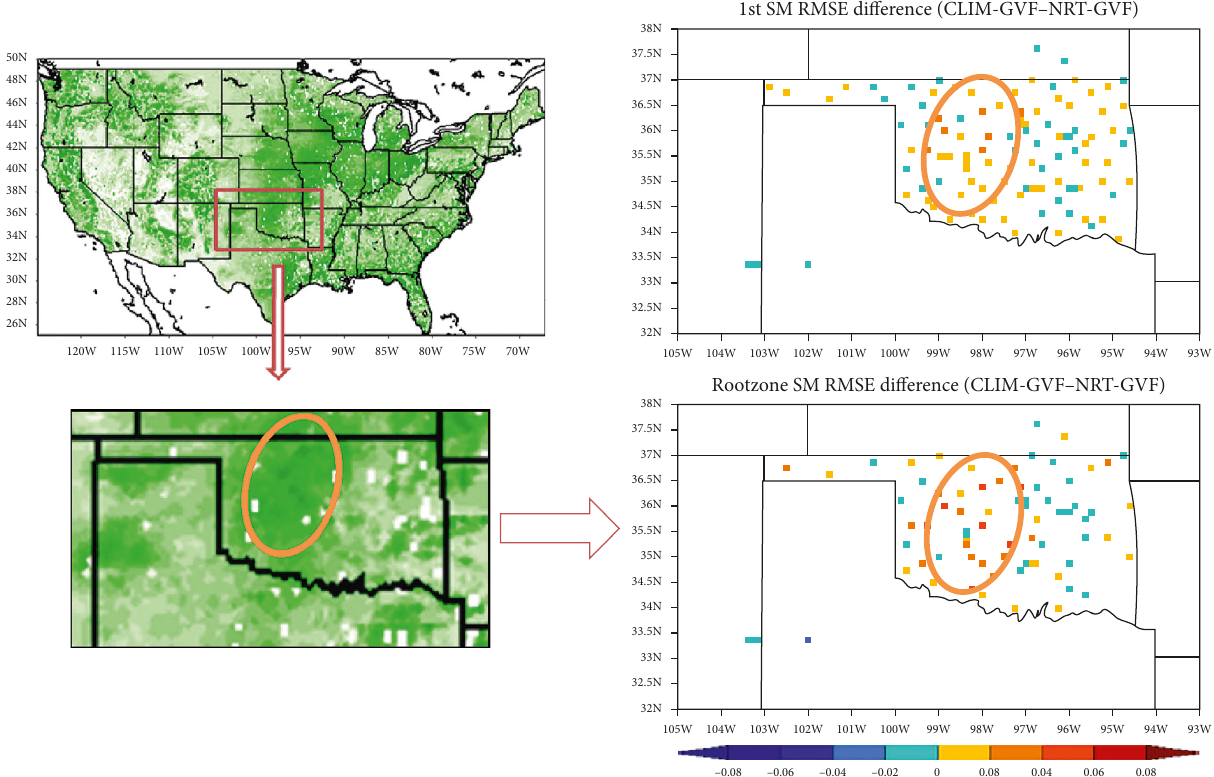
Figure 3: NRT GVF impact to Noah surface and root zone simulations over